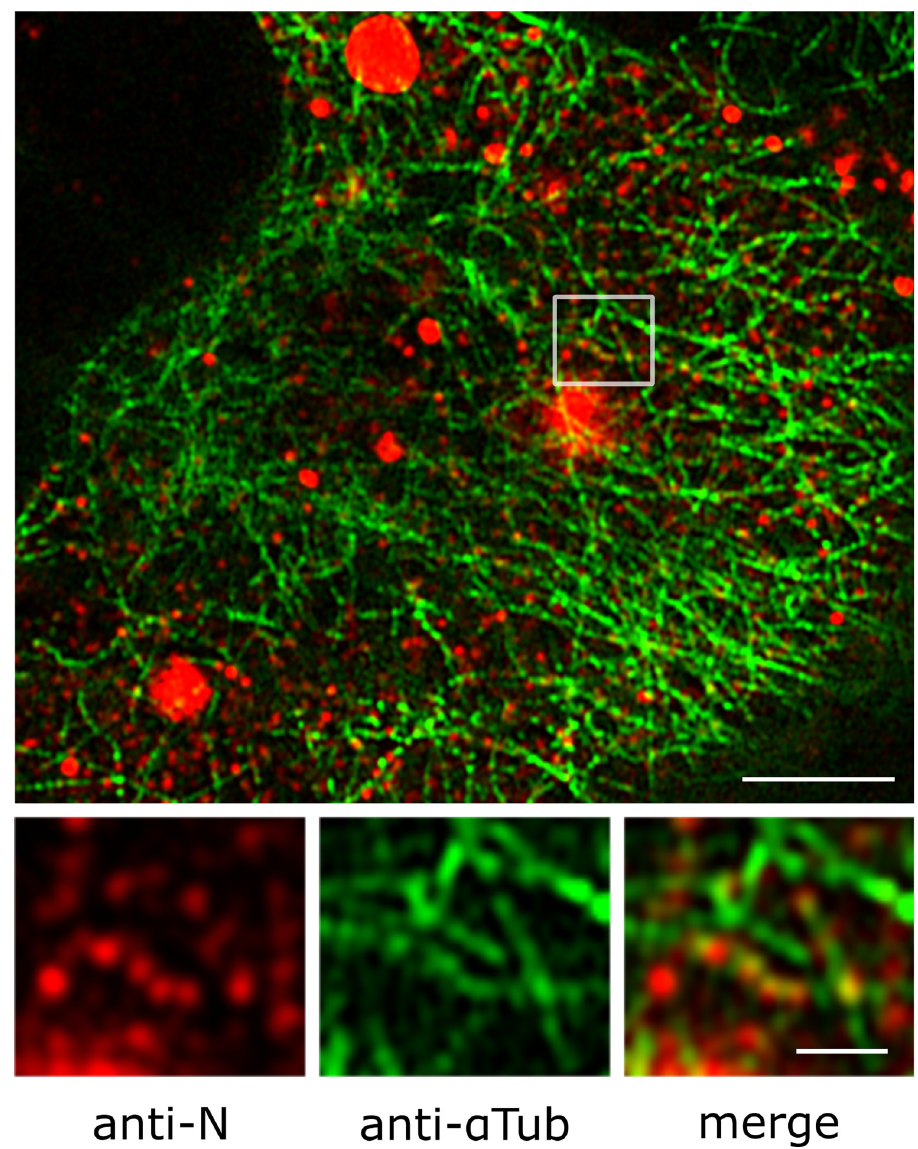
Fig 3. RNPs are decorating the MT network. A549 cells were infected with RSV for 20h. N (in red) and α -Tubulin (in green) are revealed by immunostaining. High-resolution images were generated using a confocal microscope with Airyscan detector. Images were visualized after gaussian filter fixed at 0.5. A representative image of a whole cell out of 5 cells in 3 experiments is shown. RNPs decorating the MT network are shown on the zoom area. Scale bars 5 μ m and 1 μ